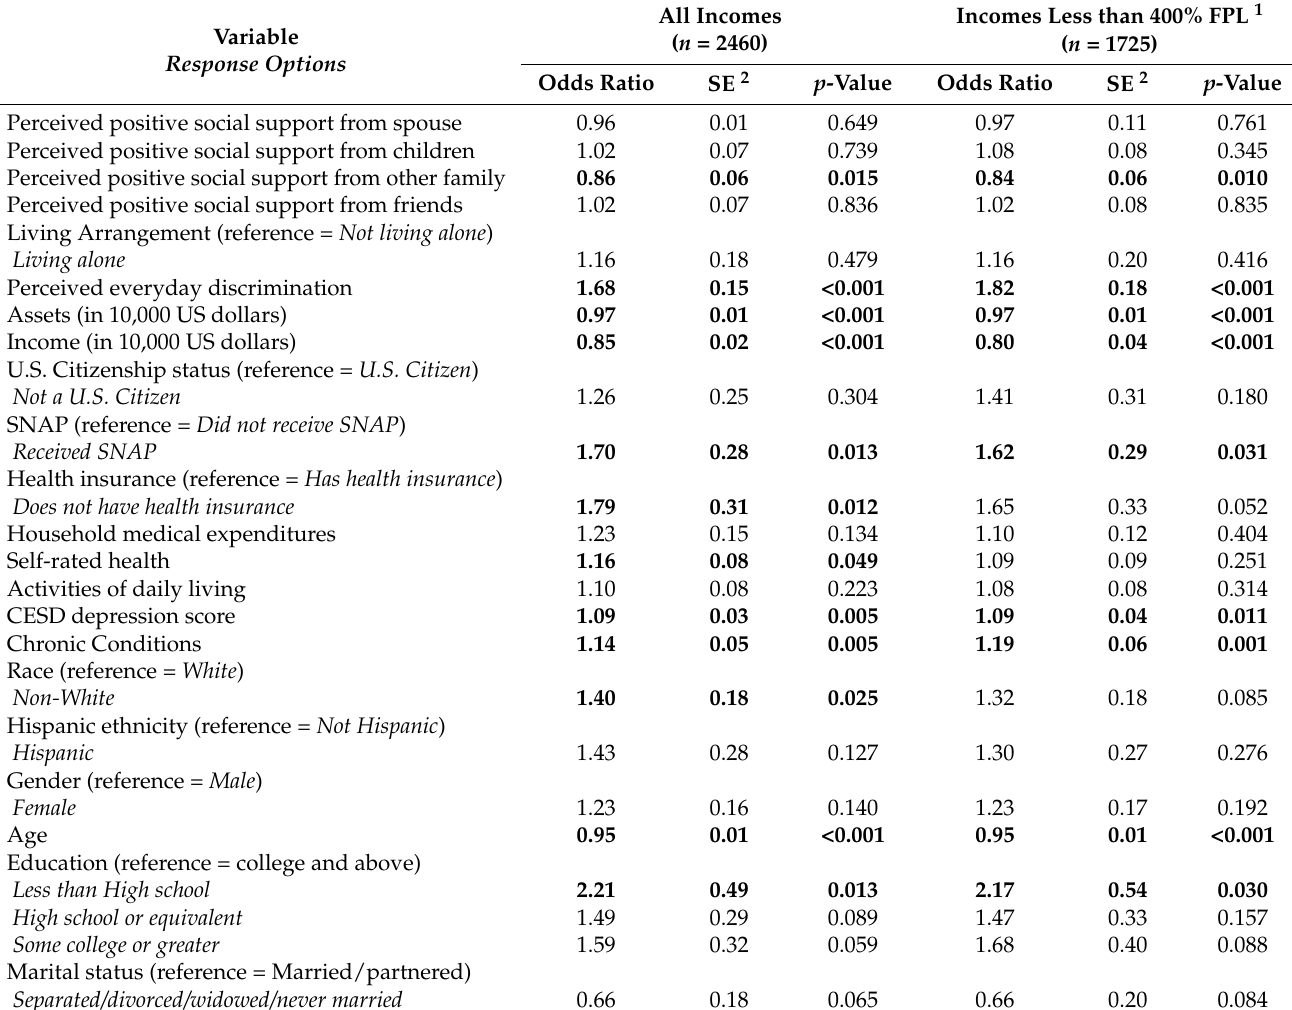
Table 3. Results of logistic regression estimating the odds of experiencing food insecurity in adults aged 50 years or more as a function of social vulnerability (perceived positive social support from spouses, children, other family, and friends), cultural vulnerability (perceived everyday discrimination), economic vulnerability (value of vehicles, primary residence, and non-housing financial weather and yearly income), and political vulnerability (U.S. citizenship status) and controlling for demographic and health-related factors for individuals with any income ( n = 2460) and individuals with incomes less than 400% FPL ( n =